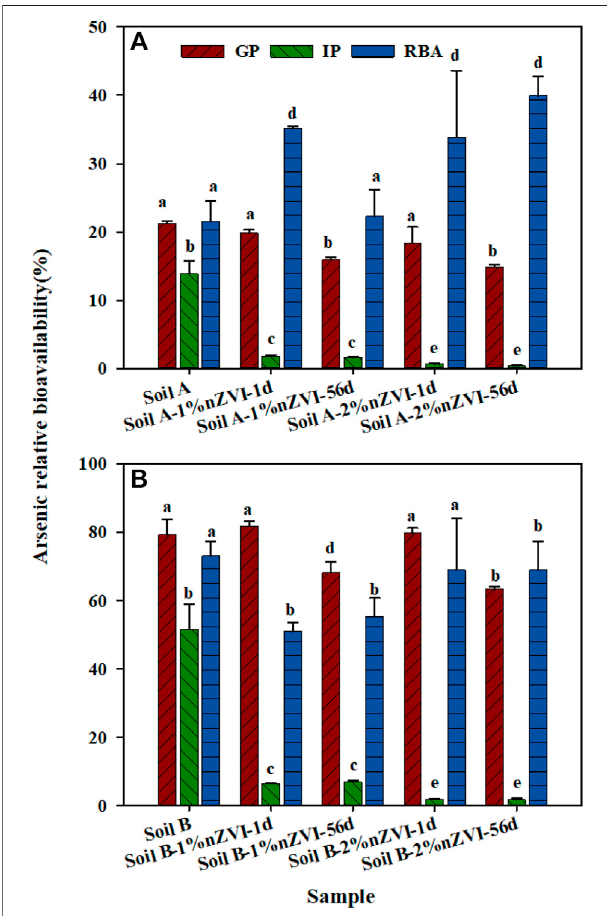
FIGURE 5 | Comparison between As relative bioavailability (RBA) and bioaccessibility measured bythe GPand IPofSBRC for (A) soilA, and (B) soil (B). Data are expressed as mean and standard deviation of triplicates. Same letters above error bars demonstrate there was no signi fi cant difference between bioaccessibility and relative bioavailability for the same